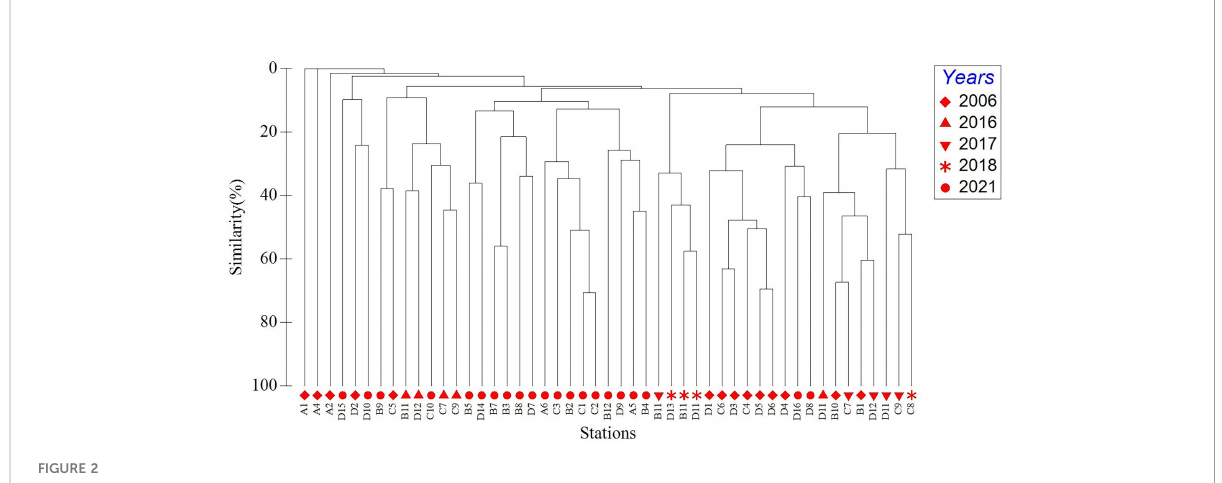
FIGURE 2 Cluster analysis of macrobenthos abundance in Hangzhou